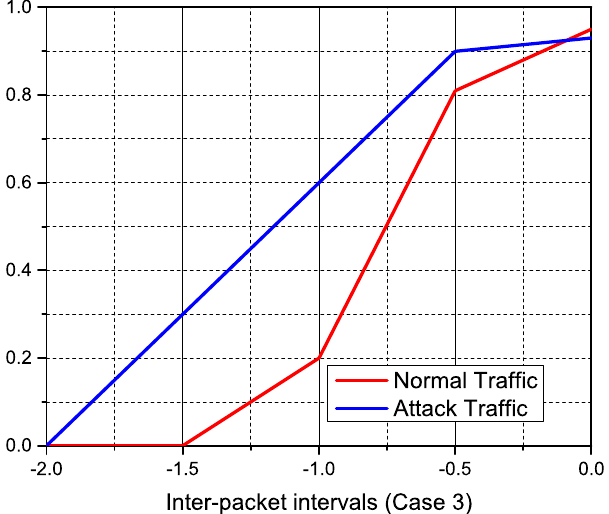
Figure 22. DDoS anomaly detection from IoT traffic feature-statistics according to the inter-packet ∆ T intervals of d 2 dt 2